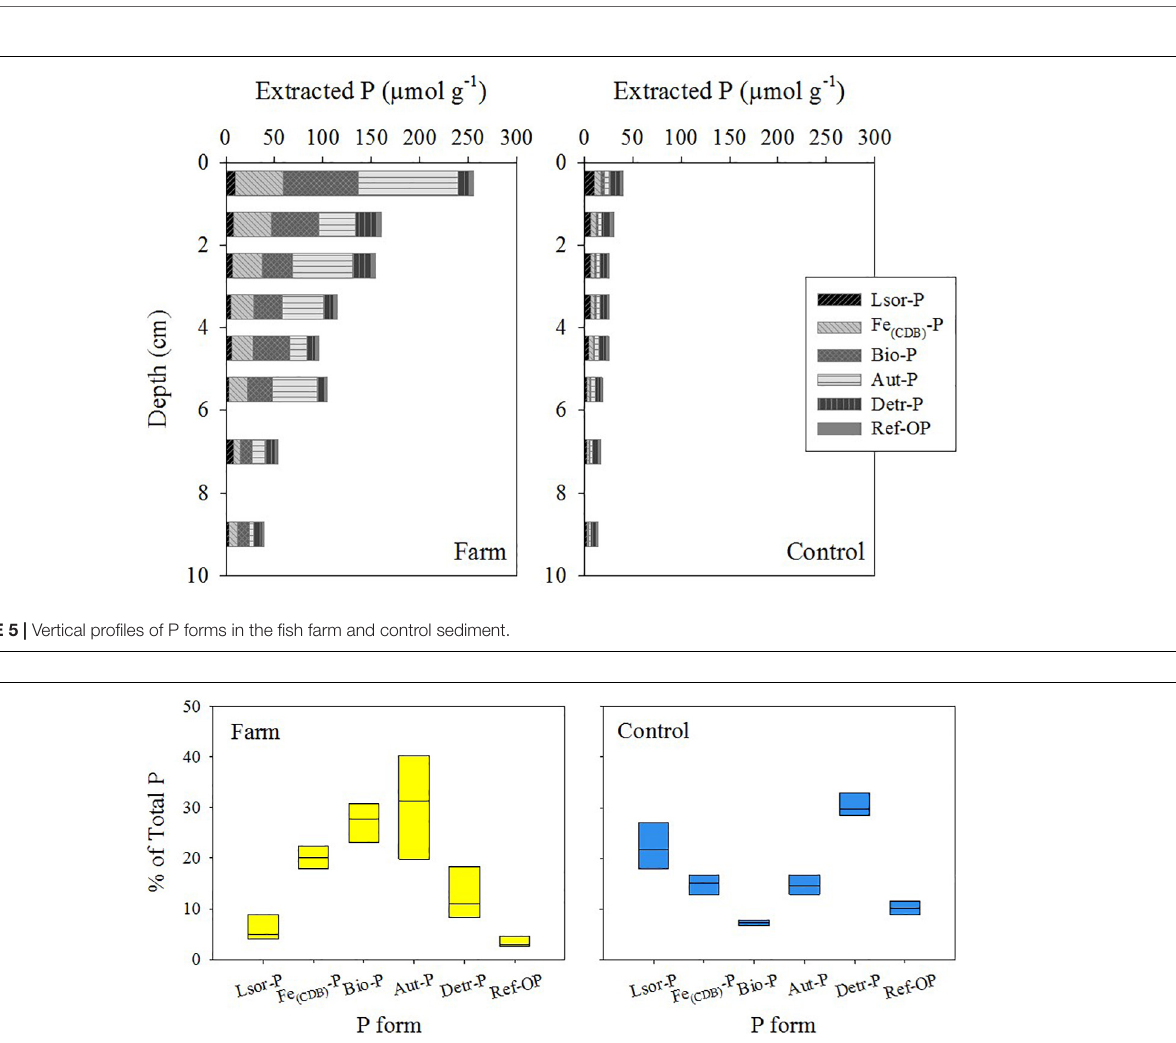
FIGURE 6 | Average proportion (%) of P forms within a depth of 10 cm of the fish farm and control sediment.